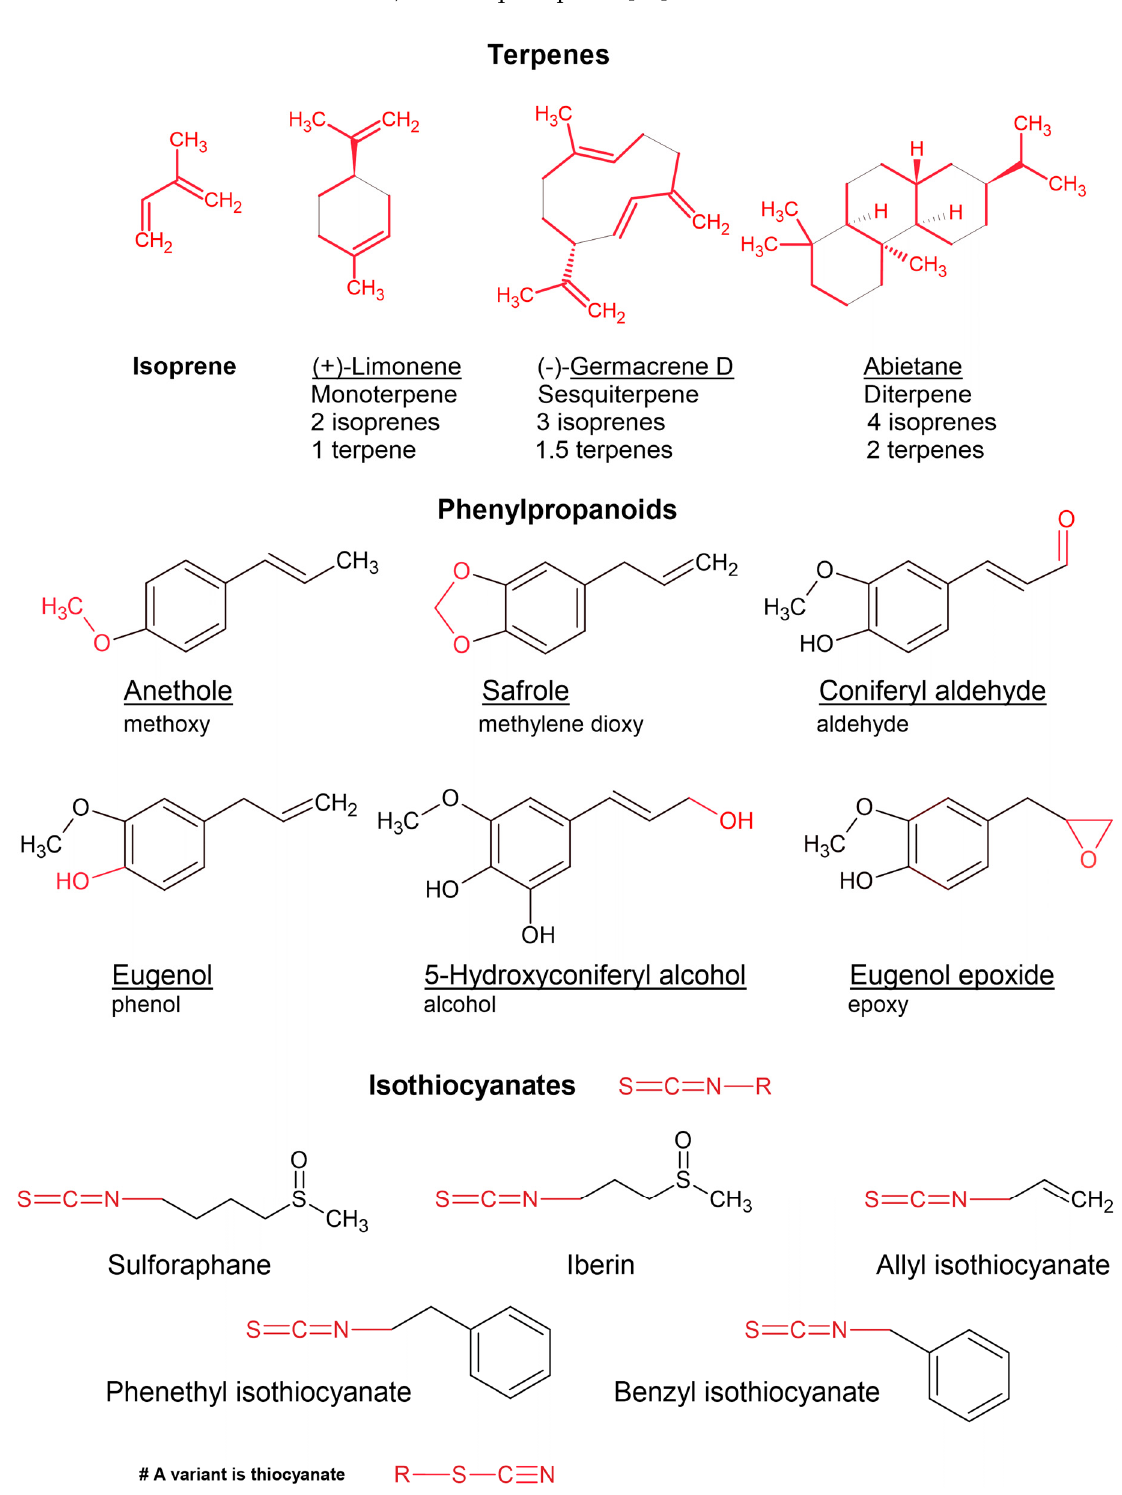
Figure 1. Examples of terpenes (with isoprene units indicated by red highlighting), phenylpropanoids, and isothiocyanates.